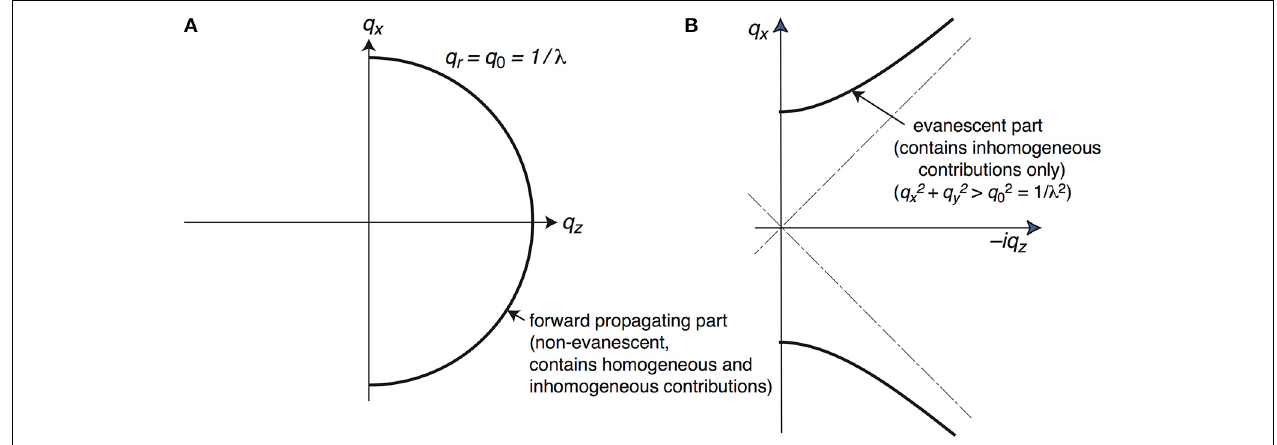
inhomogeneous parts of the Green function transform in 3D (Equation 28). (B) The evanescent part of the Green function transform resides on a hyperboloid of one sheet in q x , q y , − iq z space (Equation